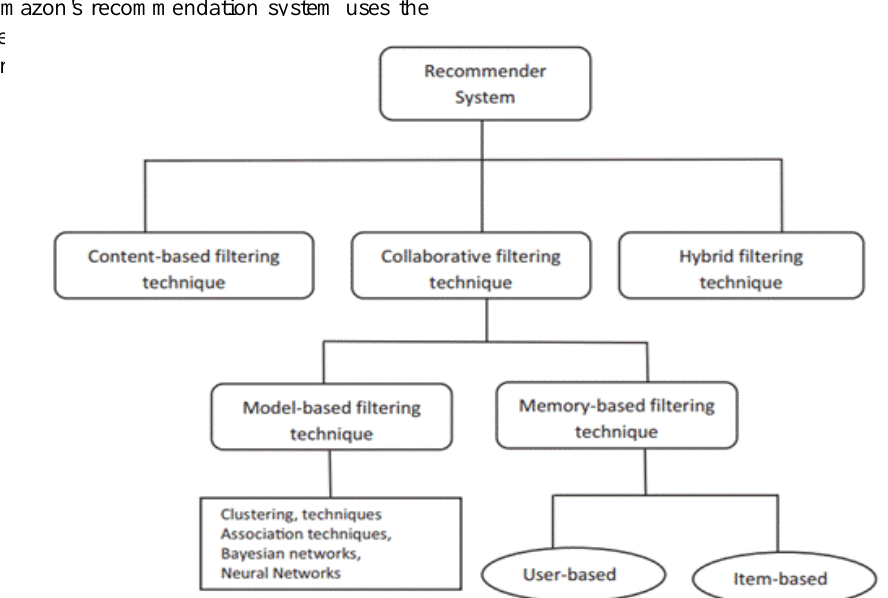
Figure 1. Recommender systems methods flow